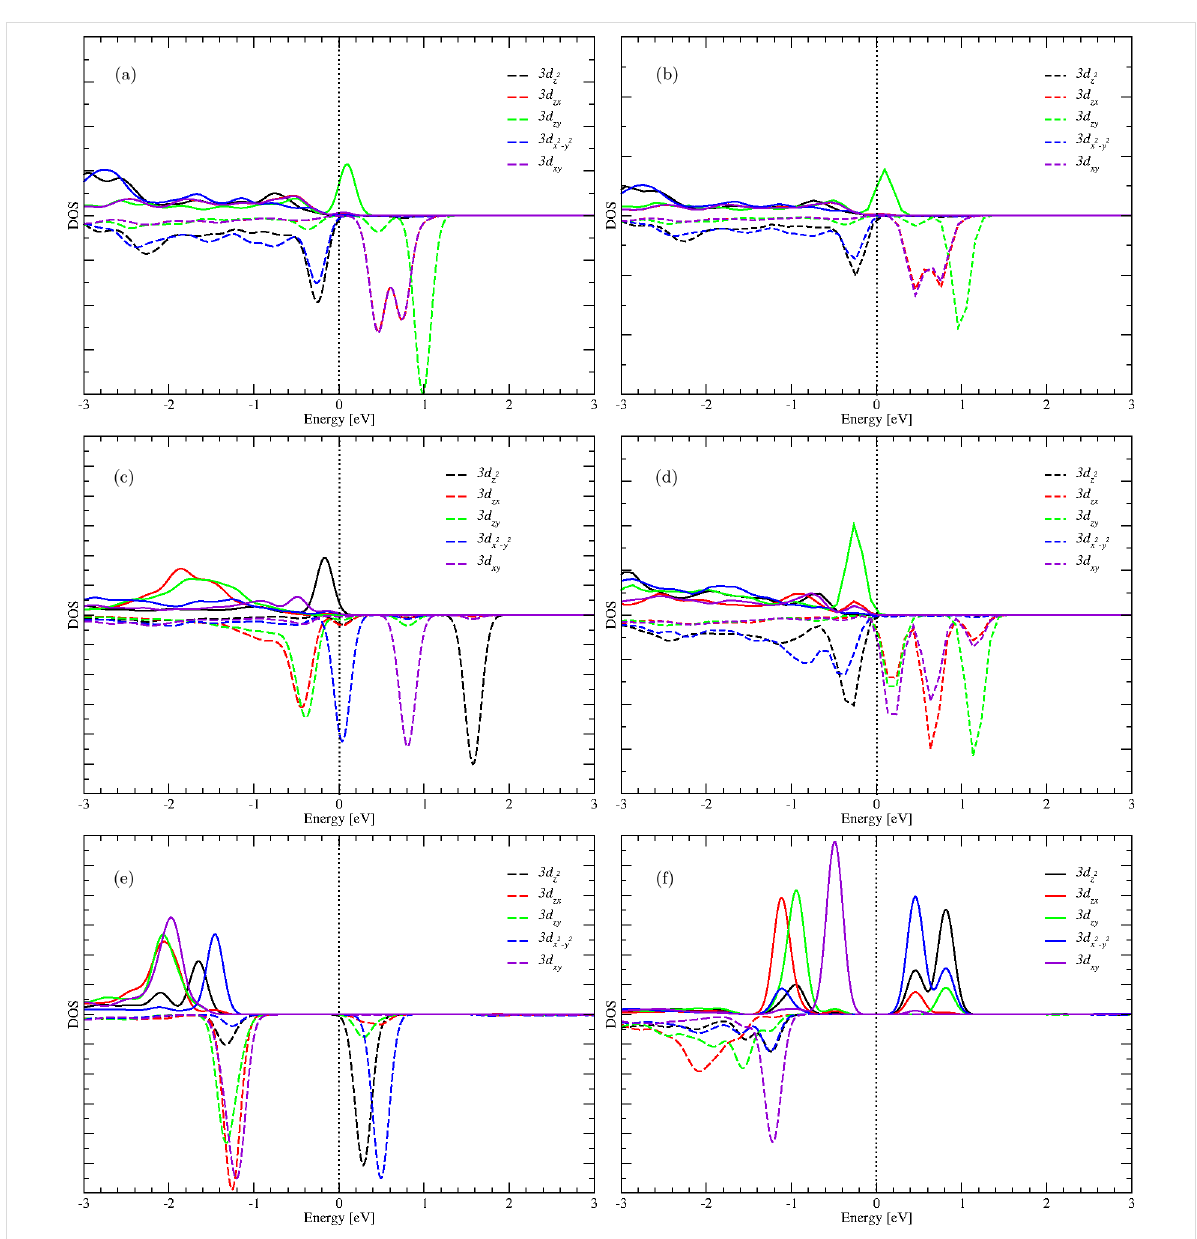
Figure 4: Projected densities of states (PDOS) of nickel atoms Ni1 and Ni2. The solid line corresponds to spin-up polarization, the dashed line corre- sponds to spin-down. (a, b) Nickel atoms Ni1 (spin-up) and Ni2 (spin-up) in tetrahedral geometries, belonging to the doped structure S 0 . (c, d) Nickel atoms Ni1 (spin-up) and Ni2 (spin-up) in trigonal bipyramidal and tetrahedral geometries, respectively, belonging to the doped structure S 1 . (e, f) Nickel atoms Ni1 (spin-up) and Ni2 (spin-down) in octahedral and trigonal bipyramidal geometries, respectively, belonging to the doped struc- ture S 2